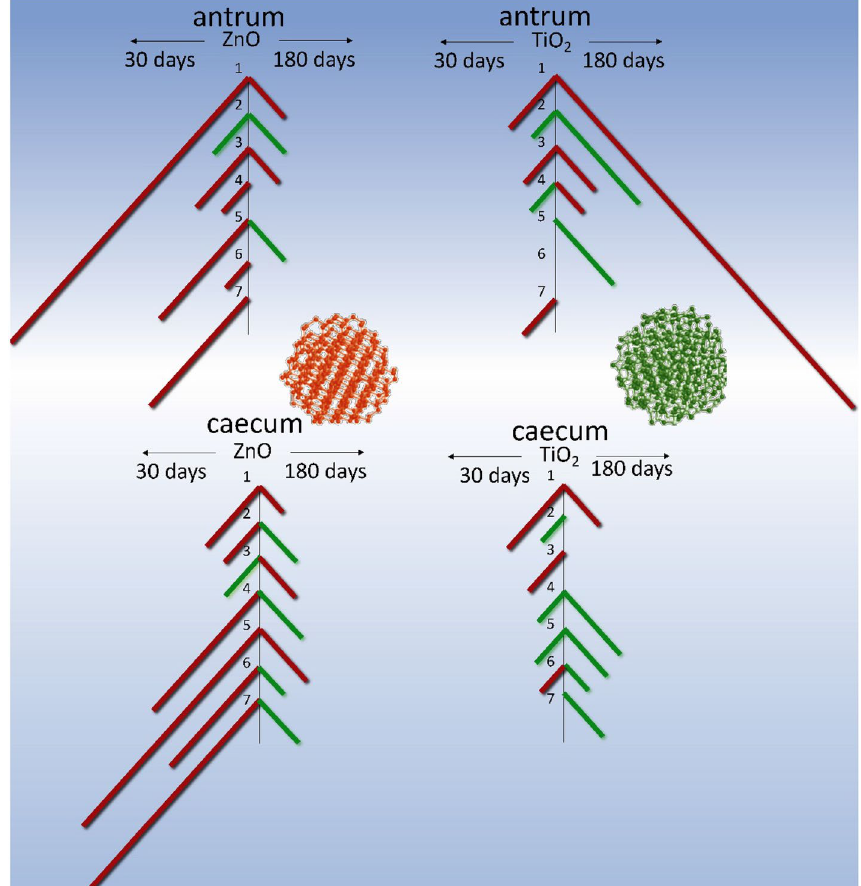
Figure 6. Scheme comparing the changes in the parameters of spontaneous and induced by acetylcholine (10 –5 M) and high-potassium Krebs solution (80 M) contractions of circular smooth muscles (SM) of the antrum and cecum of rats burdened by ZnO and TiO 2 ANs for for 6 months: ( 1 ) changes in AU contraction indices, ( 2 ) frequency of spontaneous contractions, ( 3 ) duration of the contraction-relaxation cycle; ( 4, 5 ) changes in the phase and tonic components of acetylcholine-induced SM contractions; ( 6, 7 ) changes in the phase and tonic components of high-potassium contracture of SMs. The inhibition and enhancement of the above parameters compared to control are highlighted in red and green, respectively. The figure also presents a comparison of changes in corresponding parameters of smooth muscles under burdening of rats with nanocolloids for 30 days (according to our previous study 2